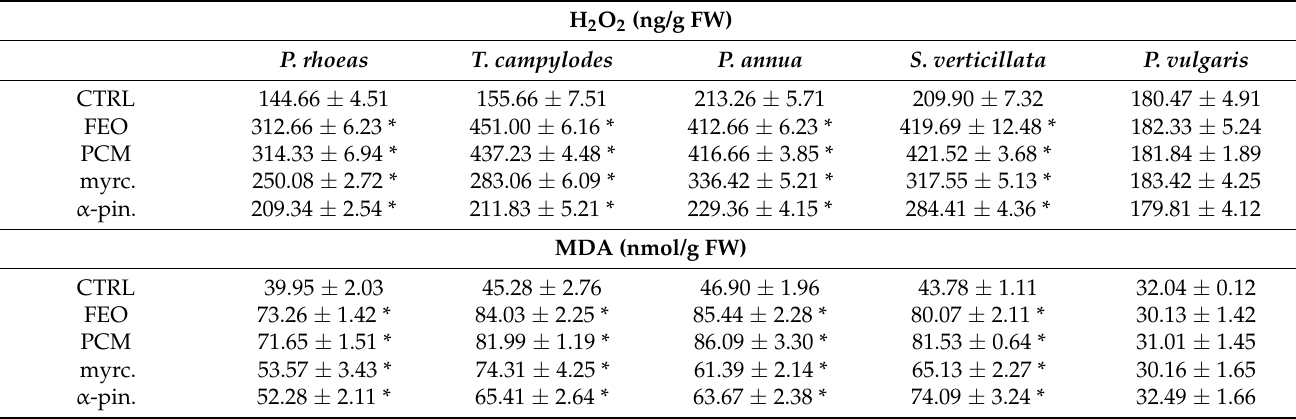
Table 4. Hydrogen peroxide concentration and lipid peroxidation level in five-day-old roots of Papaver rhoeas, Taraxacum campylodes, Poa annua Setaria verticillata, and Phaseolus vulgaris